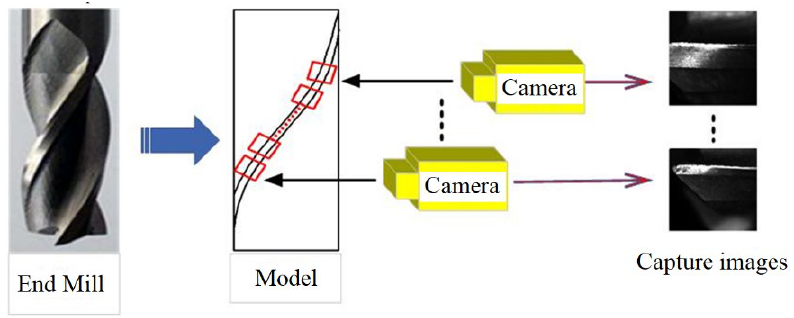
Figure 3. Schematic diagram of the process of collecting pictures of end mills.